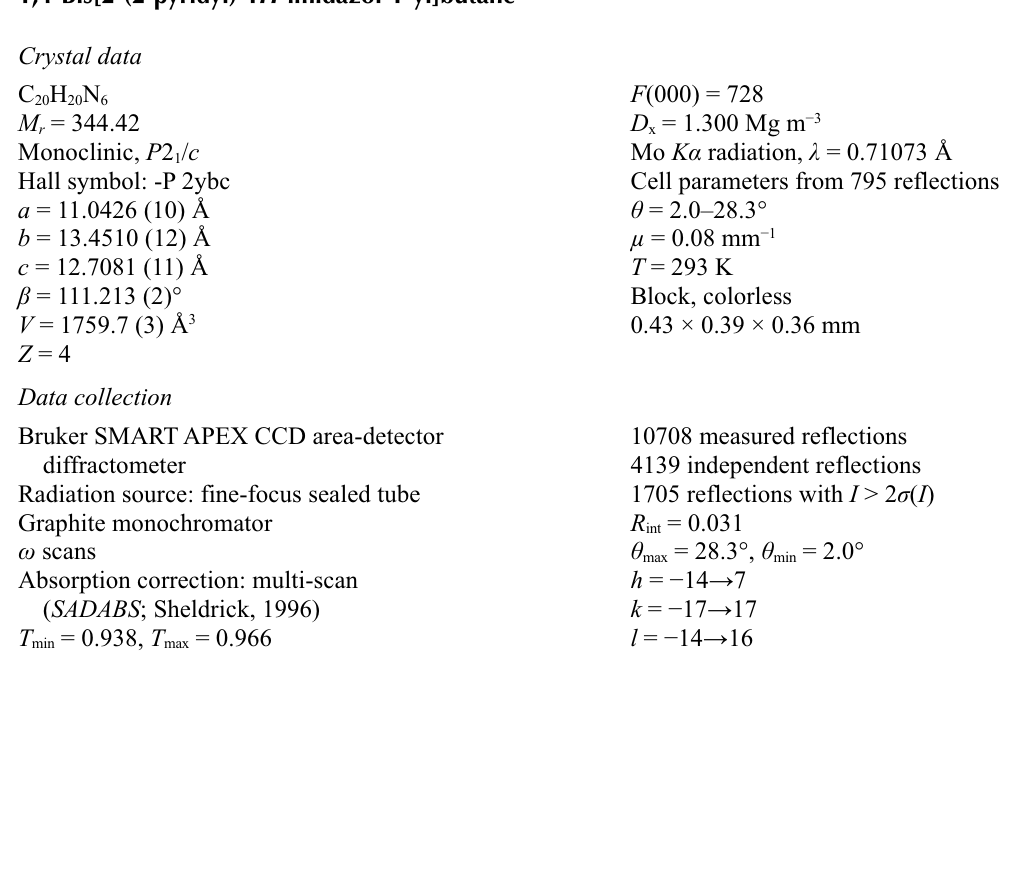
Figure 1 A view of the molecule of (I). Displacement ellipsoids are drawn at the 30% probability level. 1,4-Bis[2-(2-pyridyl)-1 H